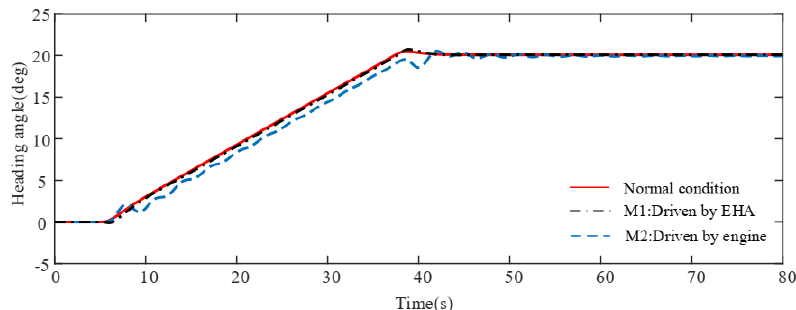
Figure 6. Bank angle response for damage scenario I.